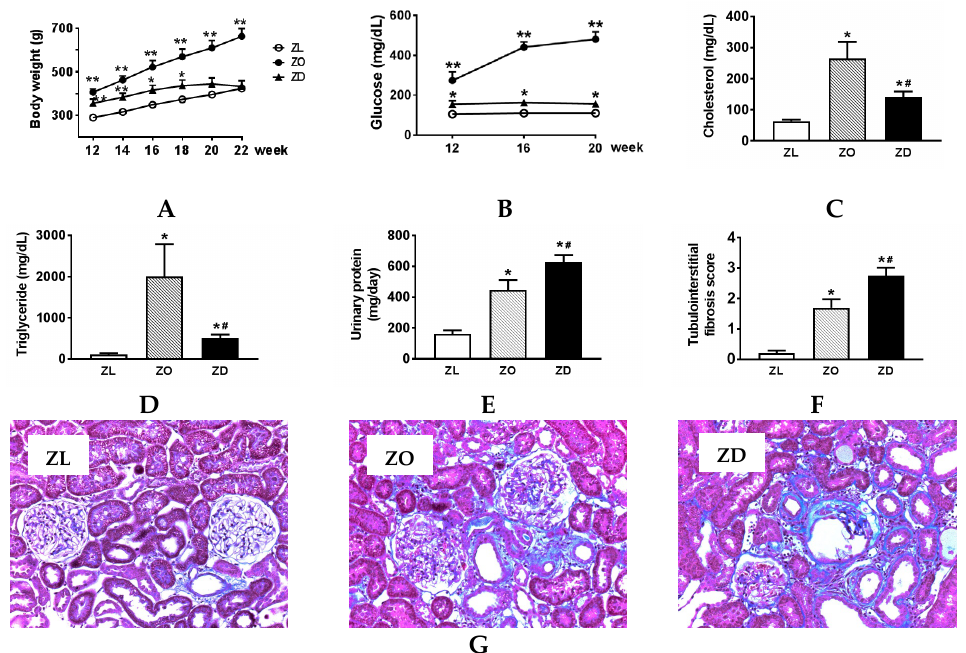
Figure 1. Metabolic abnormalities and increased kidney injury in Zucker obese (ZO) and Zucker diabetic (ZD) rats. Body weight ( A ), blood glucose ( B ), cholesterol ( C ) and triglyceride ( D ), urinary protein ( E ), tubulointerstitial fibrosis score ( F ), and representative images of Masson’s trichrome staining ( G ) in normal Zucker lean (ZL), prediabetic ZO, and diabetic ZD rats. Original magnification, × 400. Values are the mean ± SEM. n = 6 animals / group. * p < 0.05, ** p < 0.01 vs. the ZL group, # p < 0.05 vs. the ZO group.